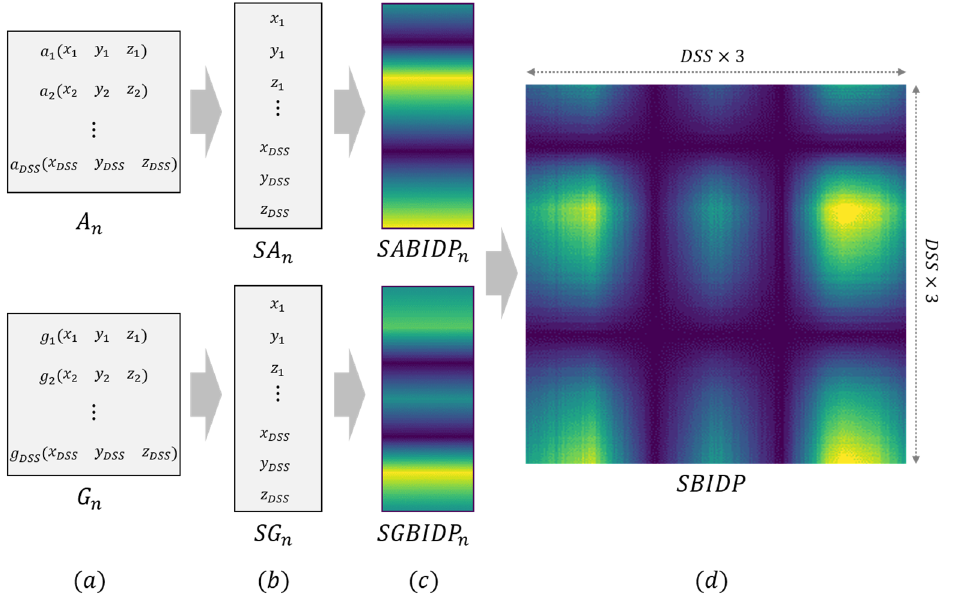
Figure 3. Example of BIDP visualization by 3-axial raw data serialization: ( a ) A n : acceleration dataset; G n : gyro dataset; ( b ) SA n : serialized acceleration data; SG n : serialized gyro data; ( c ) SABIDP n : BIDP of serialized acceleration data; SGBDP n : BIDP of serialized gyro data; ( d ) SBIDP n : serialized BIDP